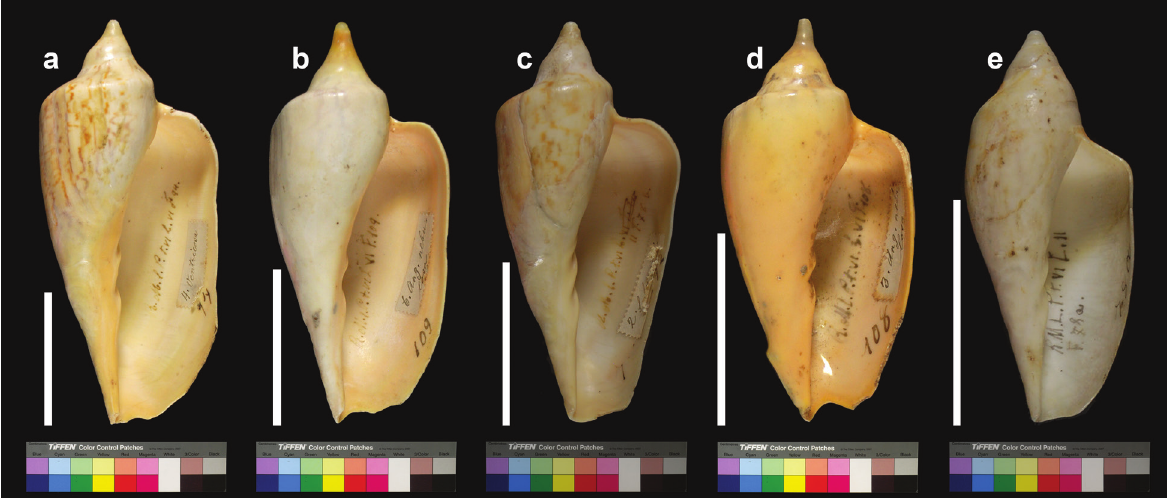
Figure 26. Voluta angulata ventricosa , specimens figured by Lahille (1895). See references on Table 9. Scale bars: 5 cm.